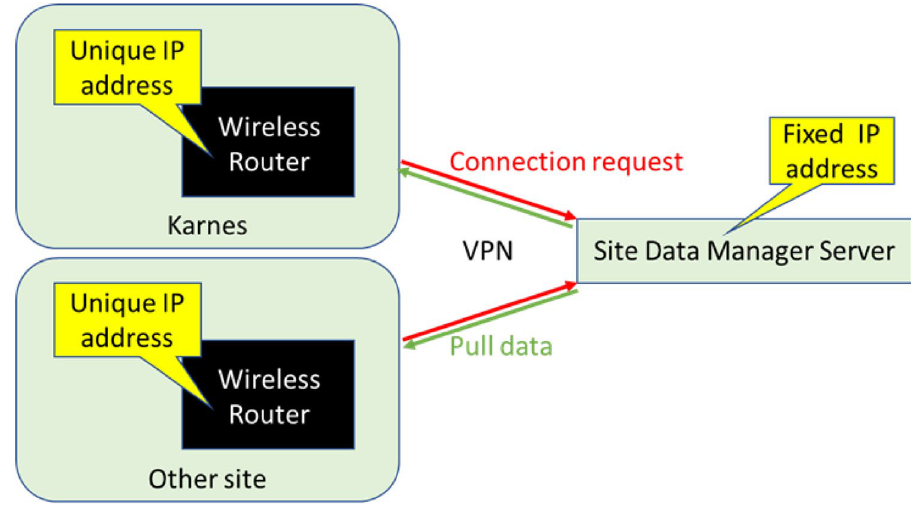
Fig. 2 Data communication between field sites and SDMS. Real-time data collected from Karnes injection site is transmit- ted to SDMS through